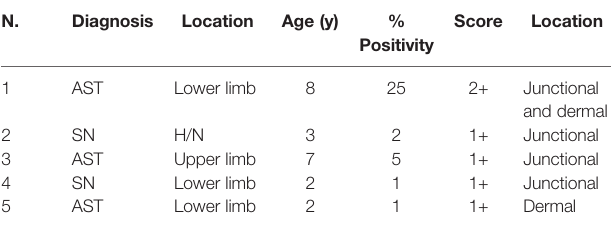
TABLE 3 | Clinical and pathological features of PRAME-positive cases.